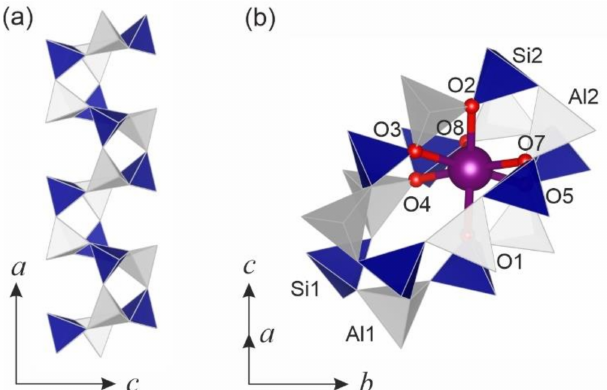
Figure 3. Fragments of the crystal structure of slawsonite: double crankshafts running along with the a -axis ( a ); SrO 7 polyhedron in ball-and-stick representation in the cavity of eight-membered rings of T O 4 ( T = Si, Al) tetrahedra ( b ). AlO 4 and SiO 4 tetrahedra are given in grey and blue, respectively. Purple and red balls indicate Sr and O atoms, respectively.